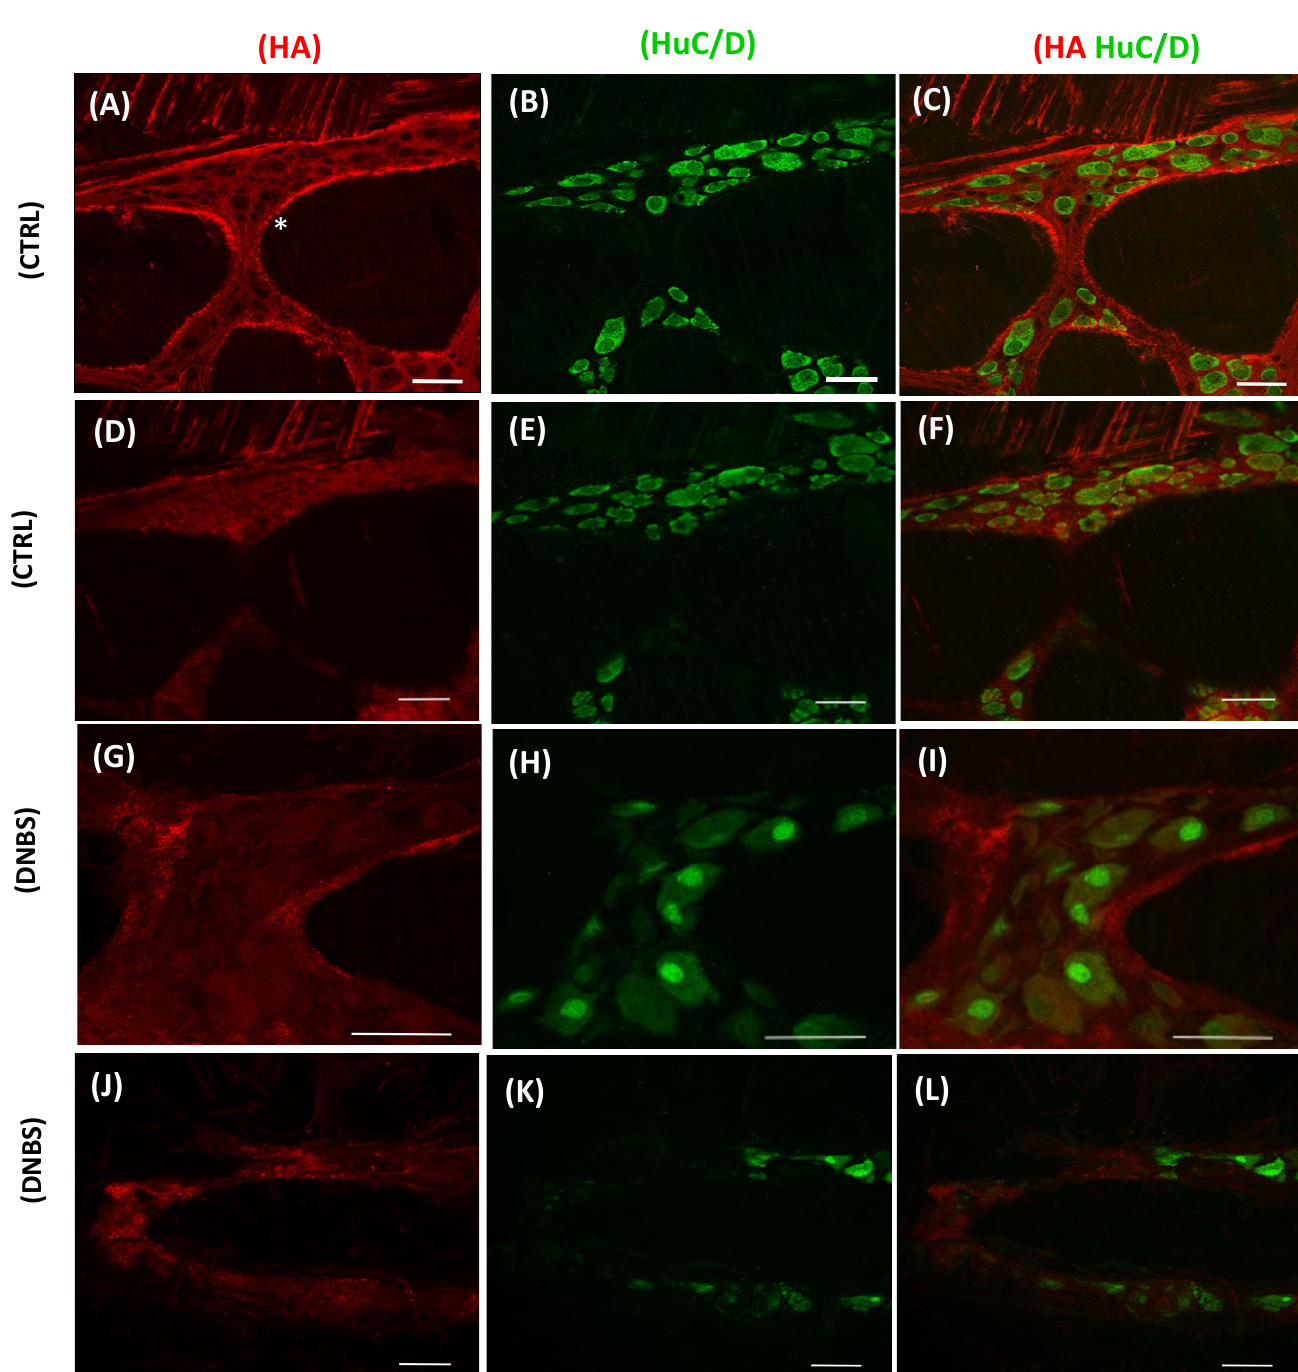
Figure 1. HA deposition in the rat colon myenteric plexus. ( A – F ) confocal image showing co- localization of HA with HuC/D (pan neuronal marker) in a median section of a colonic myenteric ganglion from control rats. HA was identified with a biotin-labeled HA-binding protein by streptavidin-FITC reaction. ( A – C ) Immunofluorescence was prevalently found in neuronal soma and in the perineuronal space. ( D – F ) HABP intensely stained the surface of the same ganglion and ( A ) interconnecting fibers (*). Bar 50 µ m. ( G – L ) Confocal image showing co-localization of HA with HuC/D in a median section of a myenteric ganglion after DNBS-induced colitis in rats. ( G – I ) HABP fluorescence was prevalently found in the soma of myenteric neurons; perineuronal staining was absent. Several neurons displayed signs of distress with nuclear HuC/D translocation and faint cytoplasmic HuC/D immunoreactivity. Bar 100 µ m. ( J – L ) HABP stained the surface of the same ganglion. Bar 50 µ m (Adapted from Ref.